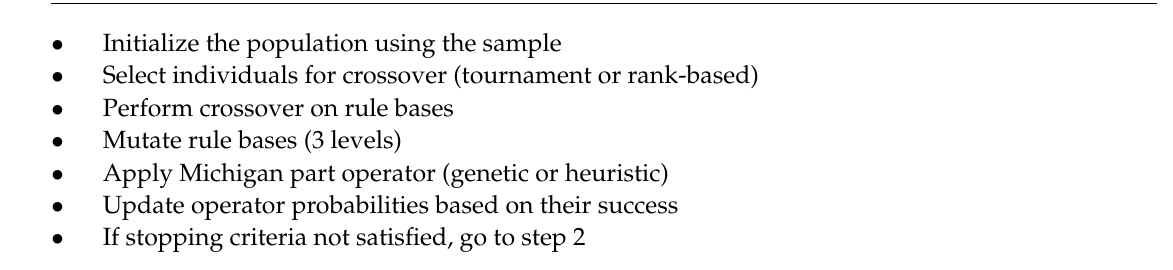
Algorithm 1 HEFCA main